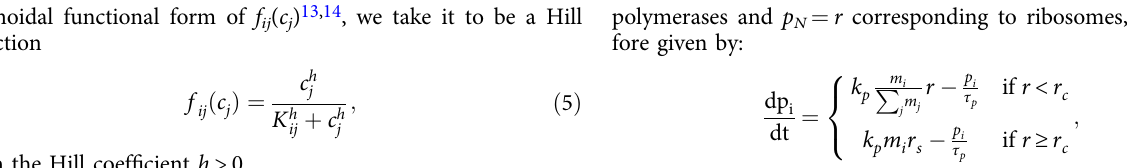
Fig. 1 Schematic illustration of the gene expression model. a The dynamics of protein and mRNA concentrations are coupled through transcriptional regulation, where some of the proteins (e.g., transcription factors) modulate the effective gene copy numbers g i and hence the transcription rate of other genes. b If RNA polymerase is in excess, transcription rate Γ m of gene i is proportional to its effective gene copy number g i . If instead RNA polymerase is limiting, Γ m is proportional to the gene allocation fraction ϕ i = g i / ∑ j g j . c Translation rate Γ p is proportional to mRNA number m i if mRNAs are limiting, and proportional to the mRNA fraction m i / ∑ j m j if ribosomes are limiting. There are four different phases of the model depending on whether RNA polymerases and ribosomes are